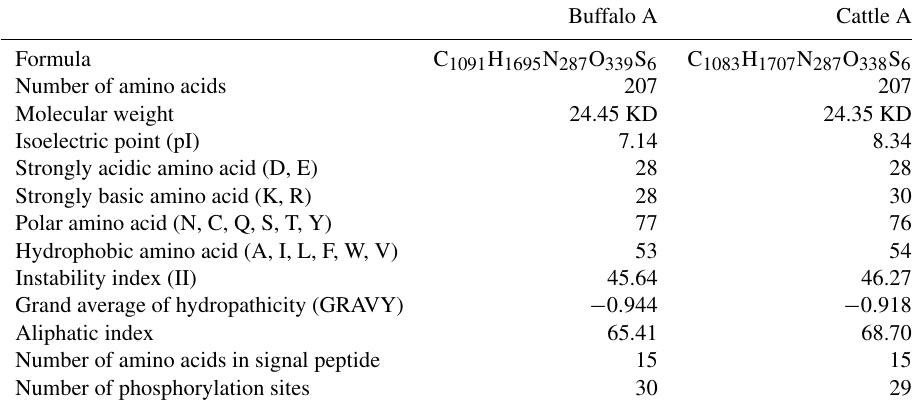
Table 5. Basic physicochemical properties of mature α S 2 -CN peptides from buffalo and